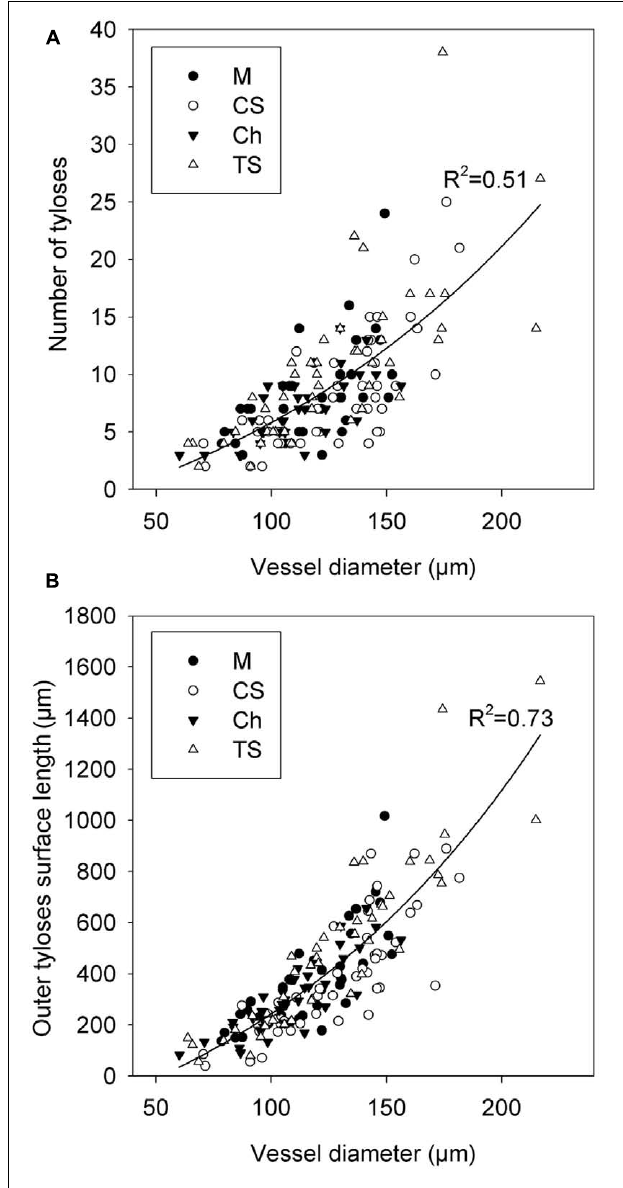
FIGURE 6 | Modeling of the effect of xylem vessel diameter on the quality of vessel occlusion with tyloses across four V. vinifera L. cultivars. (A) Graphic showing the relation between the arithmetic diameter of vessel and the number of tyloses occluding the cross-sectional area of vessel. (B) Graphic showing the relation between the arithmetic diameter of vessel and the outer tyloses surface length (OTSL). Regression curve in (A,B) represent the general model developed with data collected from the grapevine cvs Merlot (M), Chardonnay (Ch), Cabernet Sauvignon (CS), and Thompson Seedless